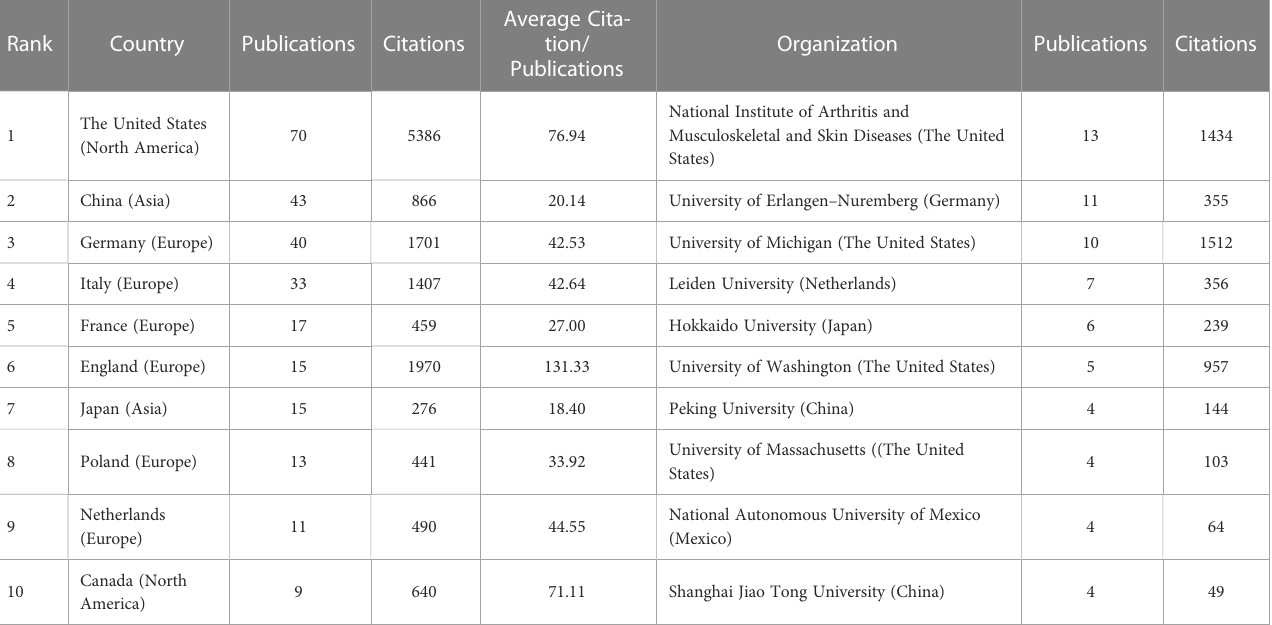
TABLE 1 Top 10 countries and organizations on the research of NETs in